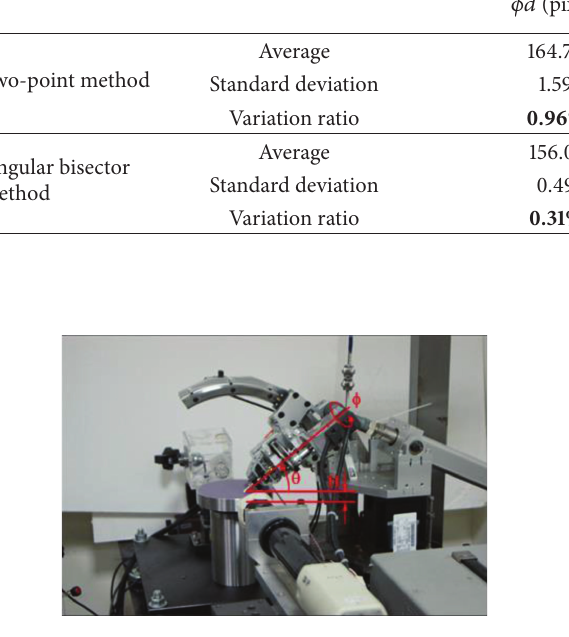
Figure 6: Photo of the 3rd generation optical fiber polishing machine.